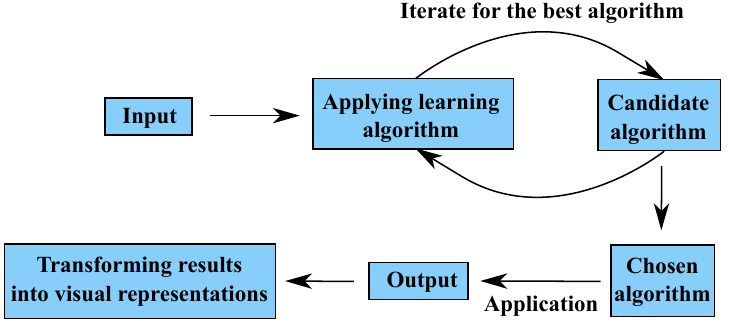
Figure 2. Learning